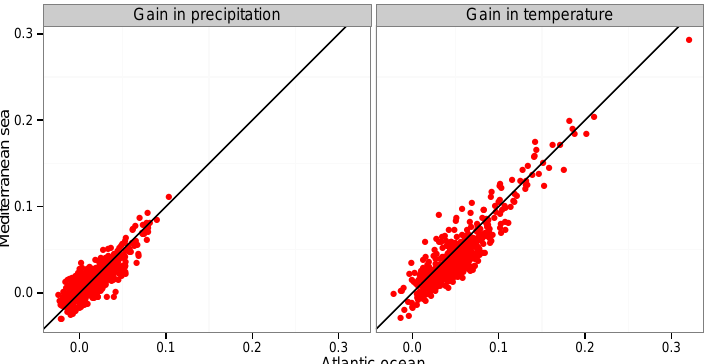
Figure B2. RMSE skill scores in precipitation and temperature for individual climatically homogeneous zones over the 1959–2007 period, calculated for a subselection of 25 analogue dates based on SST similarity on either the Atlantic and Mediterranean grid point, with the first domain selection as benchmark